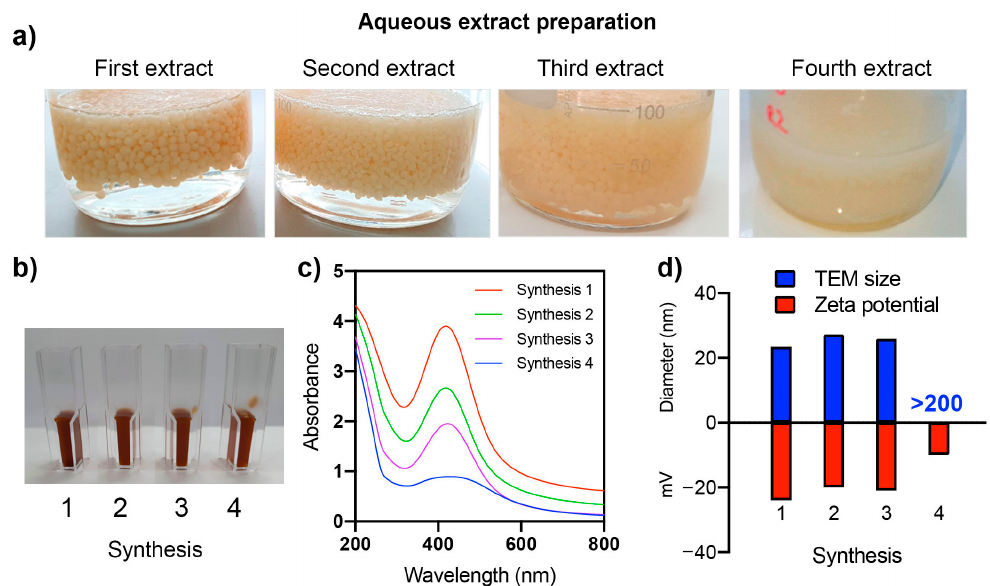
Figure 3. Multiple preparations of aqueous extracts from the same chitosan fungal beads ( a ). The appearance of dispersion ( b ), UV − vis spectra ( c ), and TEM size and zeta potential ( d ) of synthesized nanoparticles using chitosan fungal beads extracts and AgNO 3 are shown.